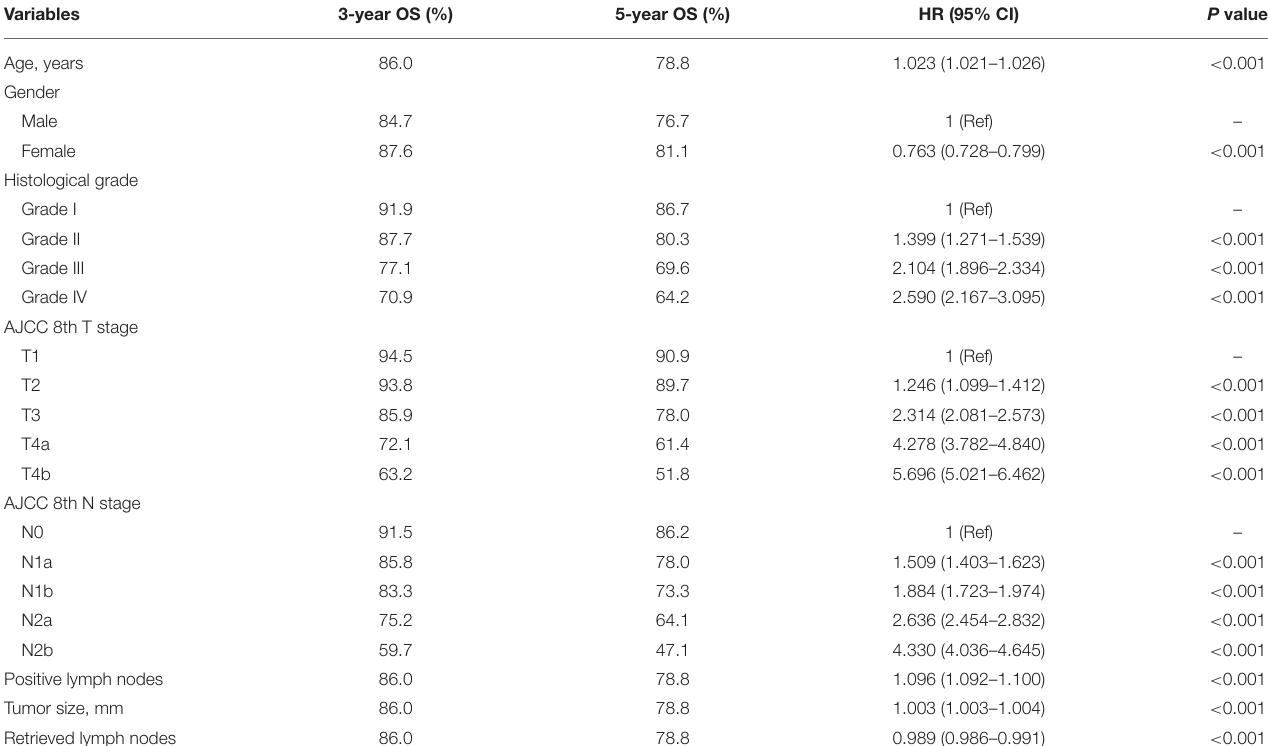
TABLE 2 | Univariate analysis of the training